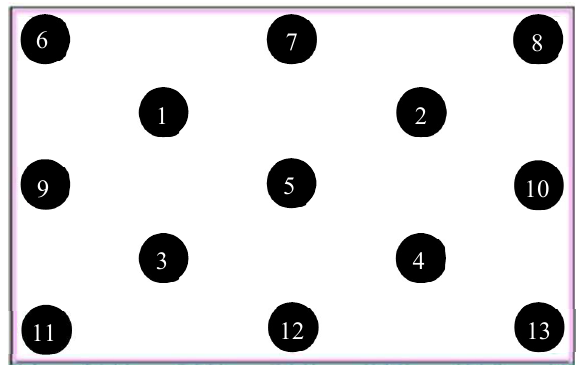
Figure 21. Thirteen-point uniformity measurement of the 17 in extra-thin, large-area, high-luminance backlight module.